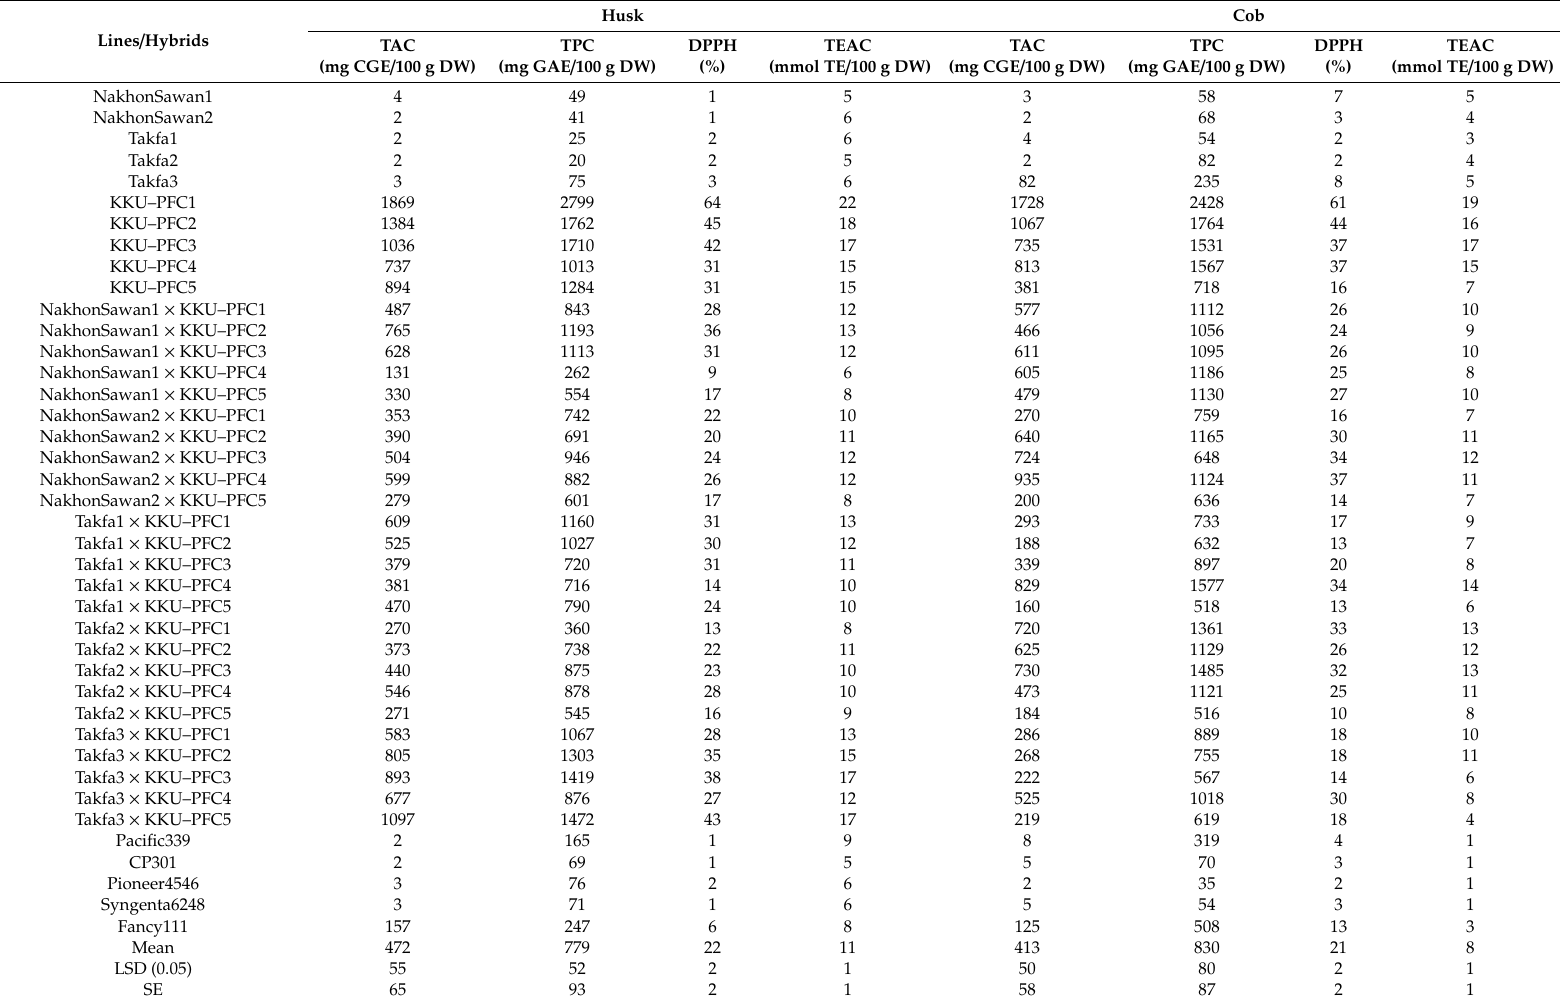
Table 9. Mean performance for total anthocyanin content (TAC), total phenolic content (TPC), and antioxidant activity determined by DPPH and TEAC method of parents and their hybrids evaluated across two locations of parents, their hybrids, and control cultivars across two locations. Lines /